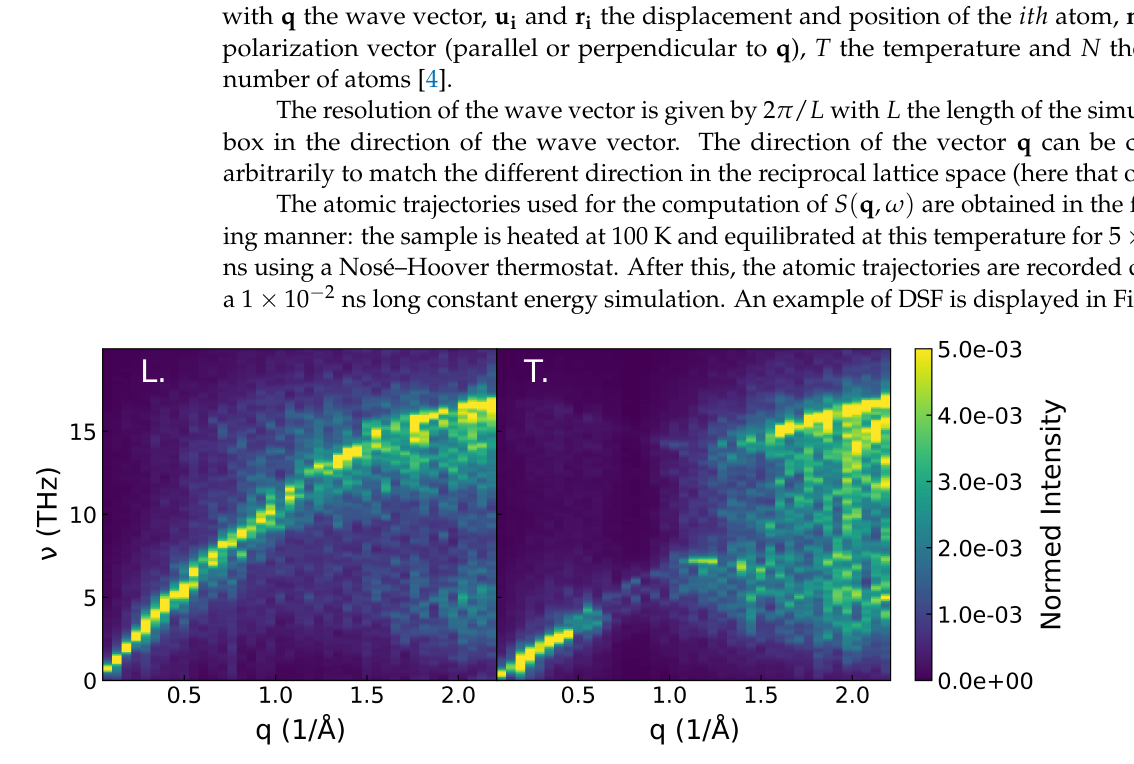
Figure 2. Dynamical structure factor computed through Equation (12) for the NW-M in the Γ X direction for the longitudinal ( left ) and transverse polarization ( right